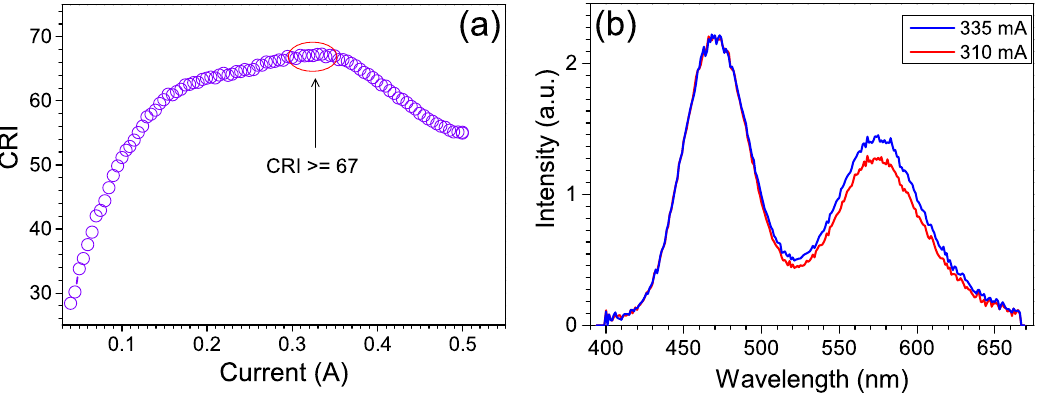
Figure 5. ( a ) Evolution of color rendering index (CRI) with increasing current; and ( b ) EL Spectrum at current values with CRI ≥ 67 with a maximum of 67.3 at 335